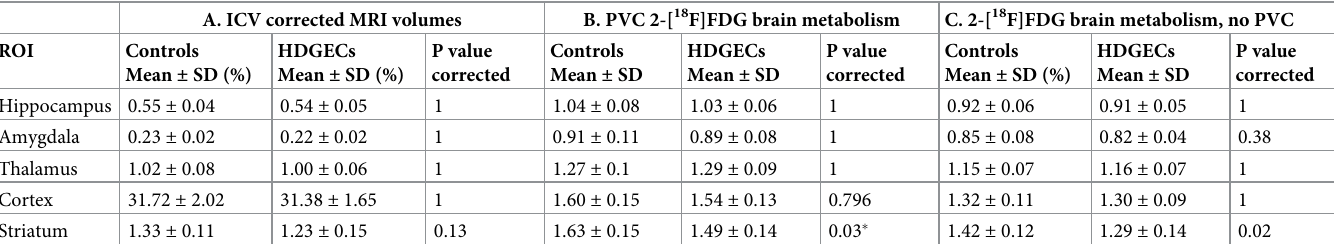
Table 2. Intracranial volume (ICV) corrected MRI volumes and Partial volume corrected (PVC) 2-[ 18 F]FDG brain metabolism.